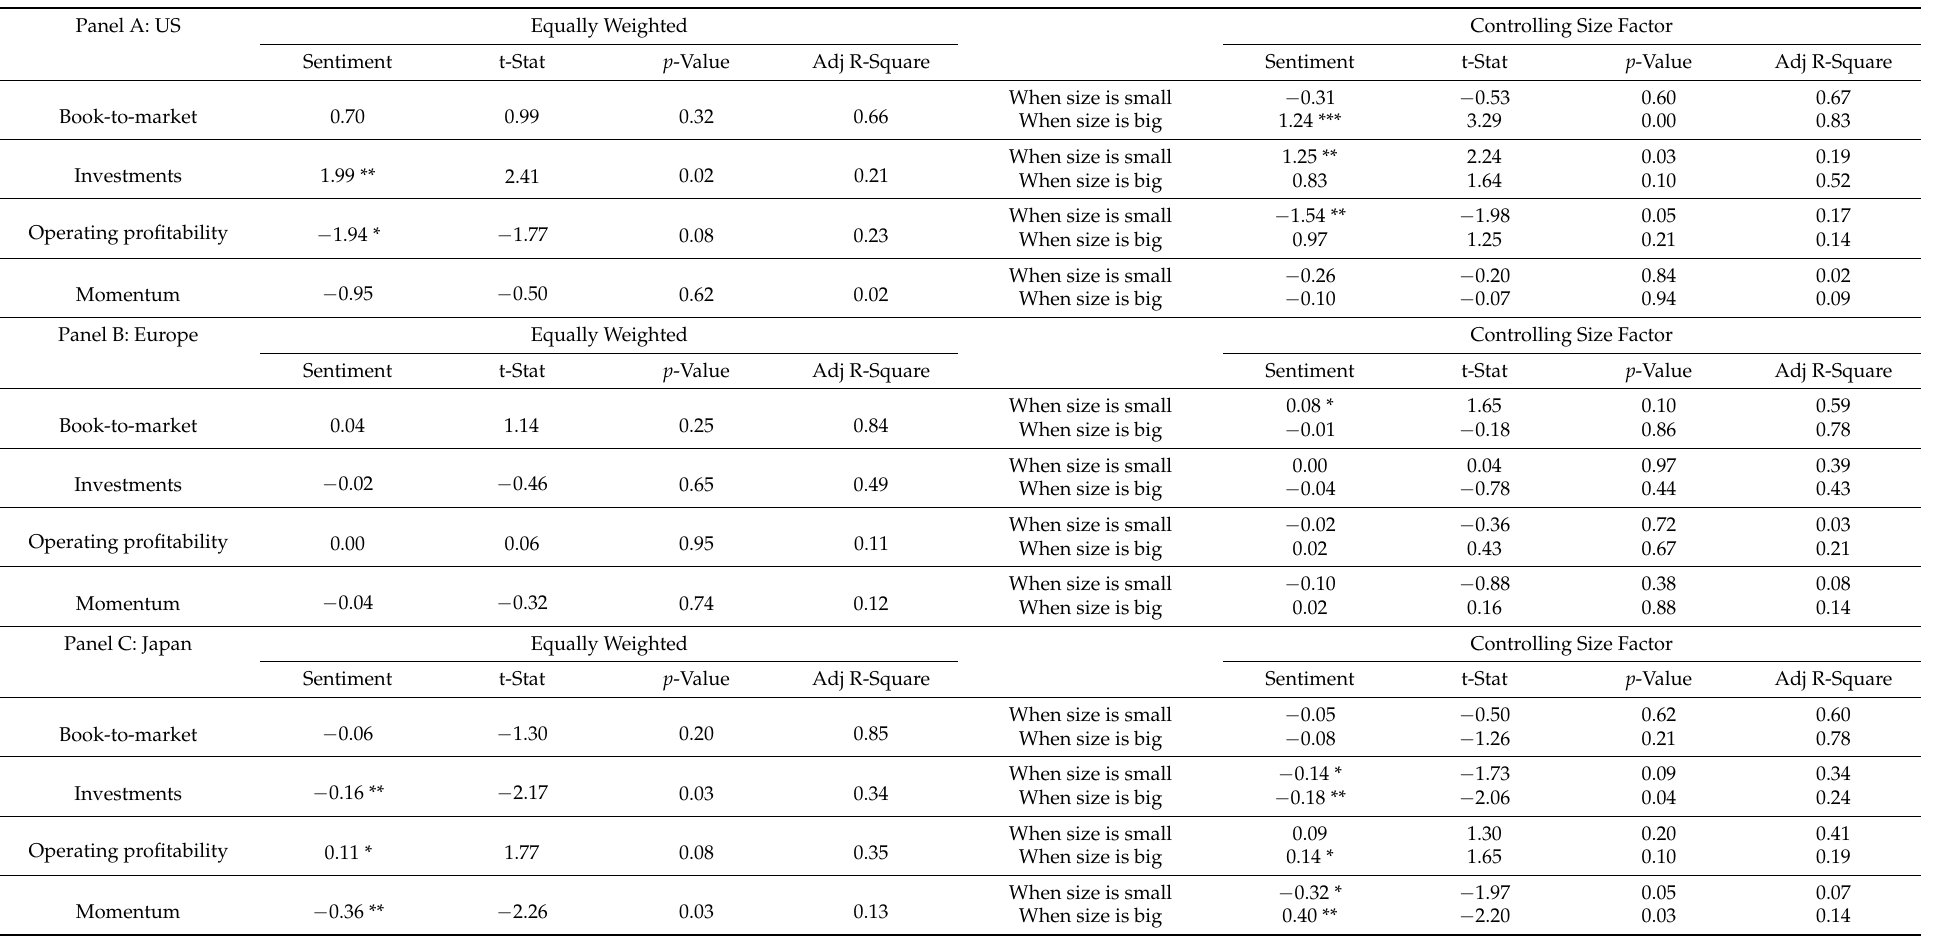
Table 9. Regression results for the combination portfolios: coefficient of the sentiment change variable in the augmented FF3F